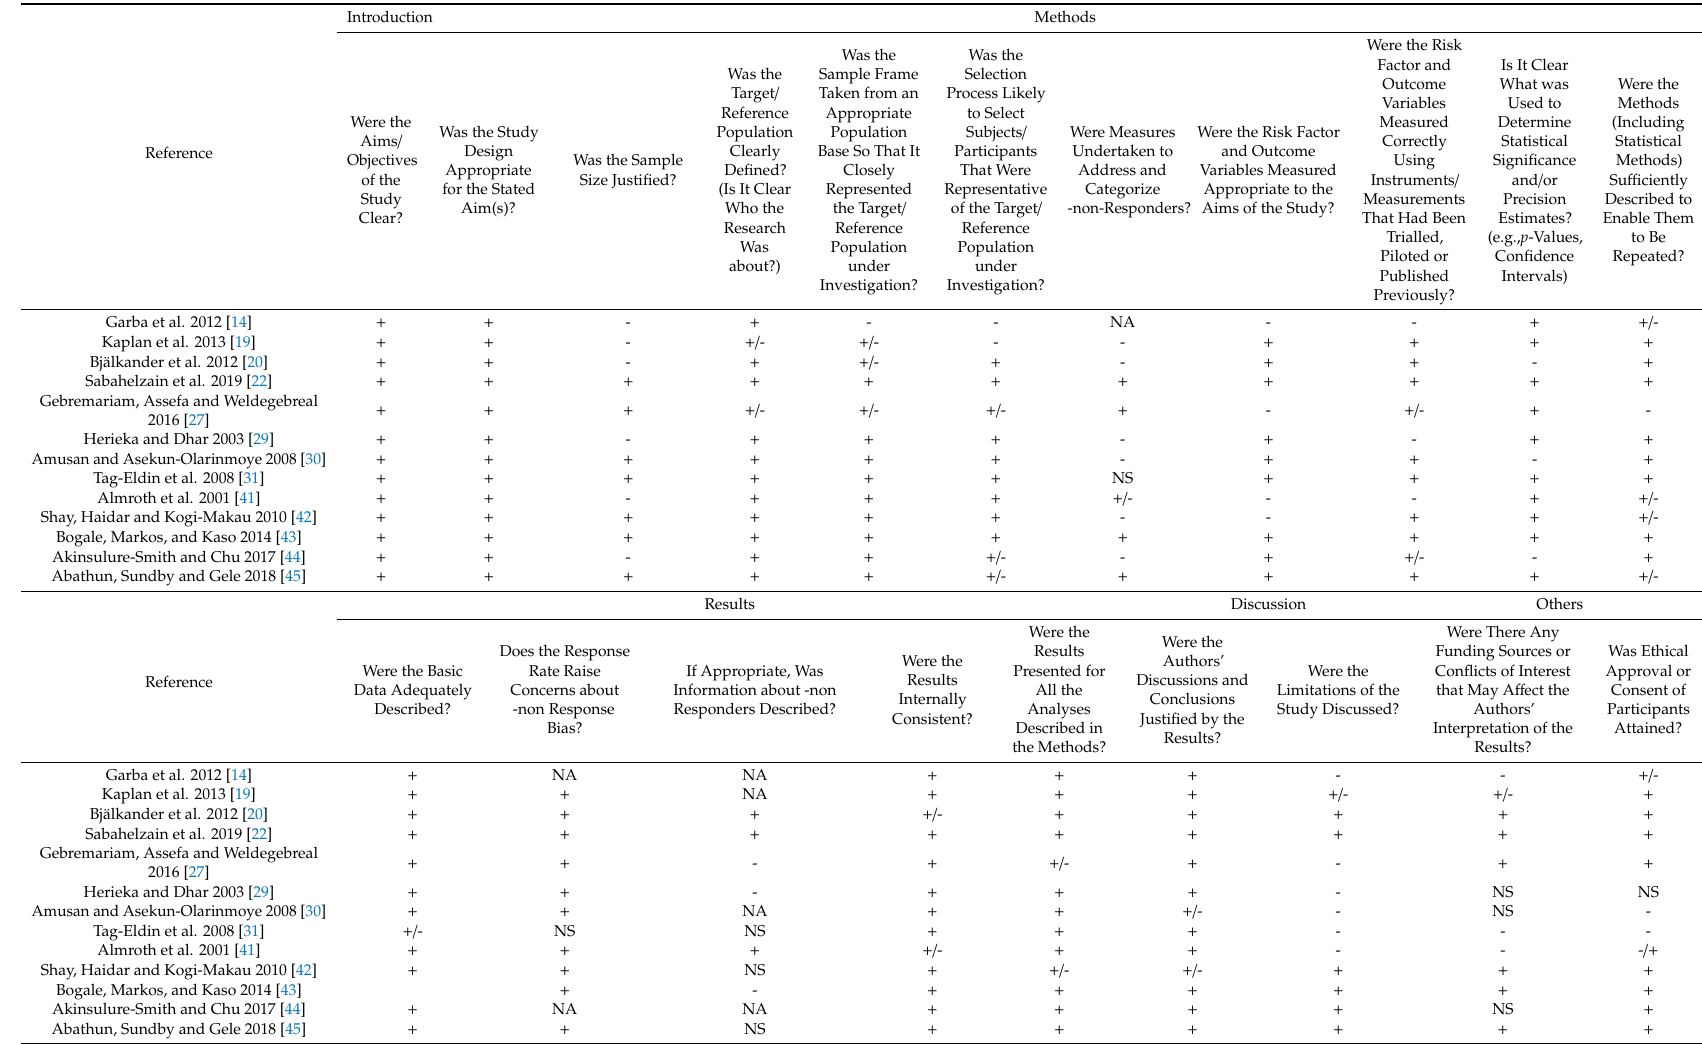
Table 4. Critical appraisal for cross-sectional studies using the Appraisal tool for Cross-Sectional Studies